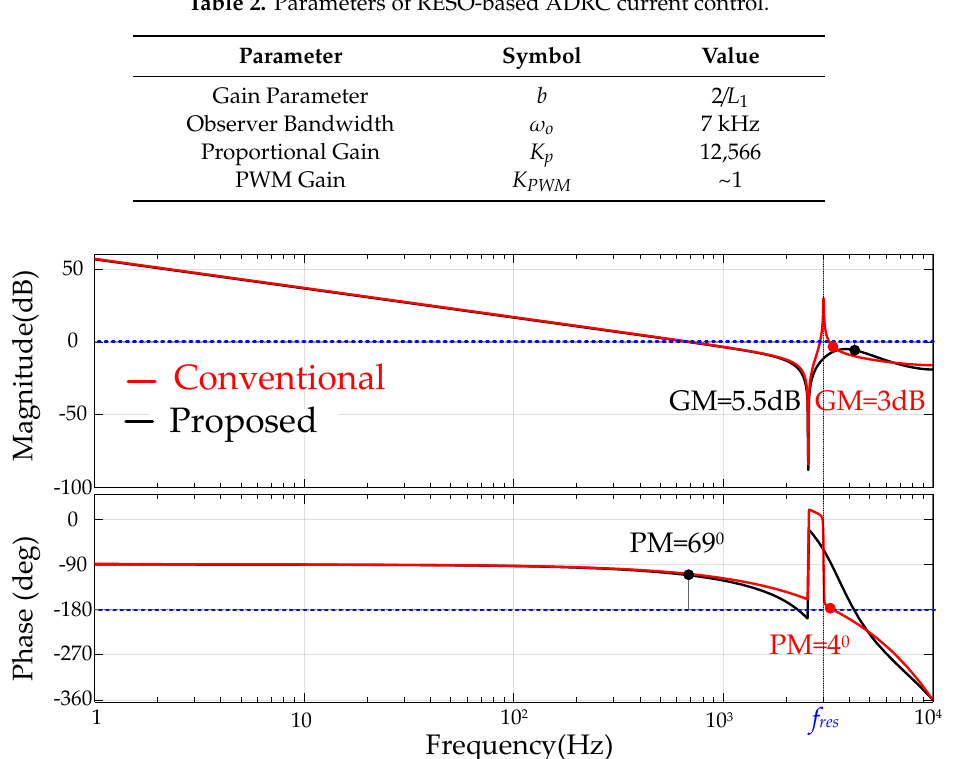
Table 2. Parameters of RESO-based ADRC current control.